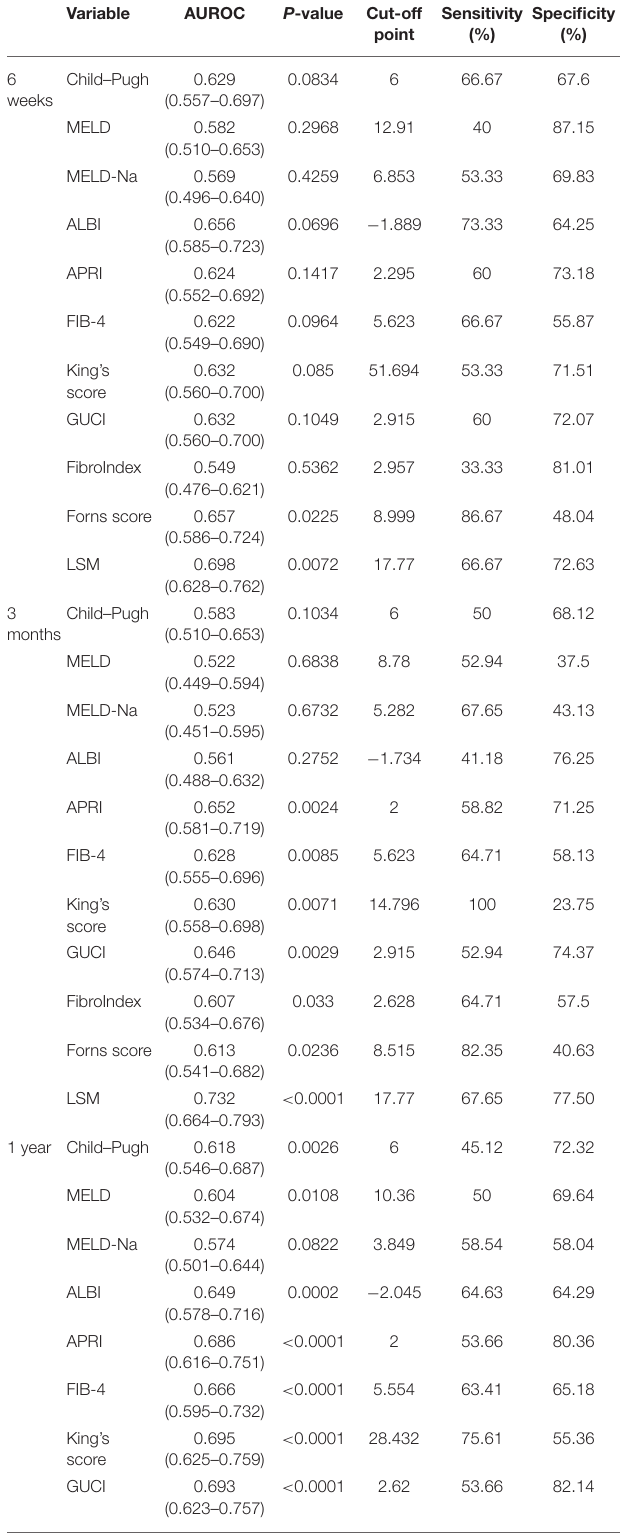
TABLE 5 | The predictive value of various parameters at different time points.